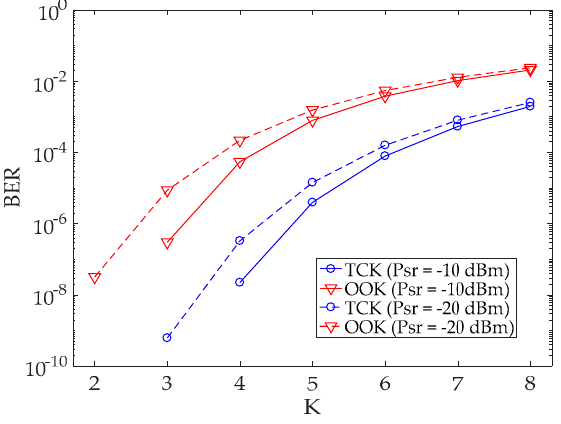
Figure 9. BER versus buffer capacity K .